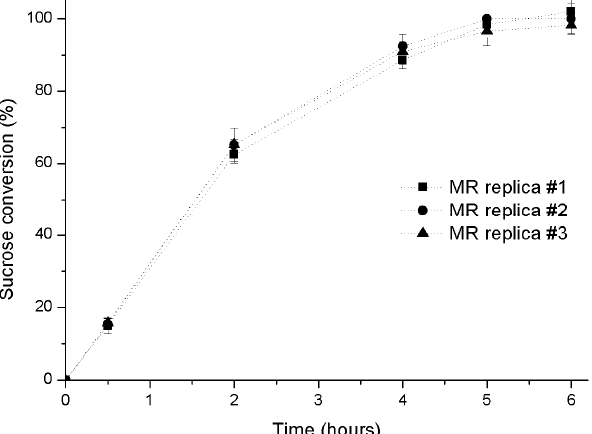
Figure 1. Conversion profiles of sucrose hydrolysis catalyzed by immobilized invertase in three microchannel reactor replicas. Five milliliters of a 5.0% ( w / v ) sucrose solutions pH 4.5 were fed to the microchannel reactors in recirculation mode at a flow rate of 3.50 mL · min − 1 . Runs were performed at 50 °C in triplicates. Error bars represent standard deviation.